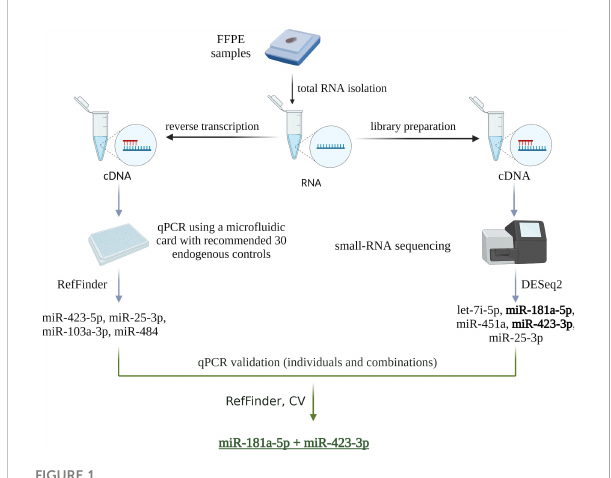
FIGURE 1 Schematic of the two endogenous control selection strategies used in this study. The fi rst strategy was based on a micro fl uidic card with 30 endogenous controls pre-selected and recommended by the manufacturer. The second strategy was based on small RNA sequencing analysis. The results of both strategies were then validated by qPCR. Individual miRNAs and their combinations were evaluated using the RefFinder algorithm and by calculating CV, which identi fi ed miR-181a-5p and miR-423-3p as the most appropriate endogenous controls. Created with BioRender.com.